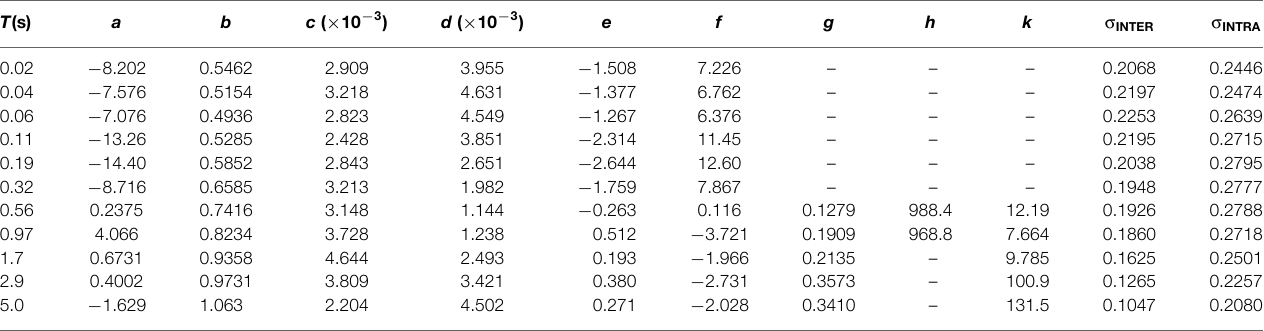
TABLE 1 | The coefficients for the ground motion prediction equation (Itoi et al., 2015) .